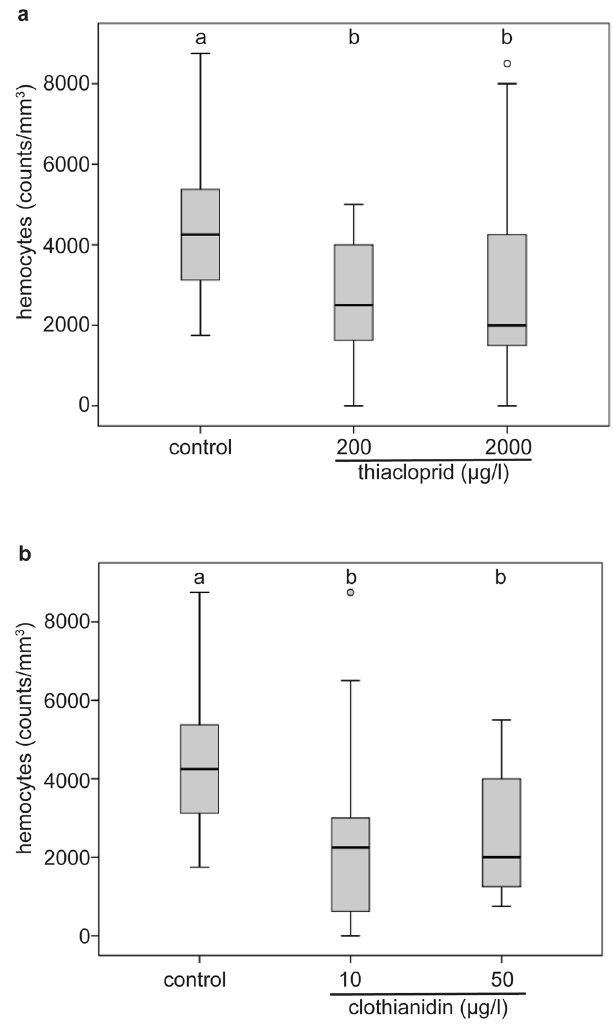
Figure 1. Exposure to thiacloprid or clothianidin reduced total hemocyte counts. The seven day-treatment of young honeybee queen with thiacloprid (( a ); control: n = 19, 200 µ g/l: n = 16, 2000 µ g/l: n = 19), or clothianidin (( b ); control: n = 19; 10 µ g/l: n = 15; 50 µ g/l: n = 14) reduced the total hemocyte counts compared to control queens. Boxes show 1st and 3rd interquartile range with black lines denoting medians. Whiskers encompass 95% of the individuals, beyond which outliers (circles) reside. Treatments with different letters differ significantly from each